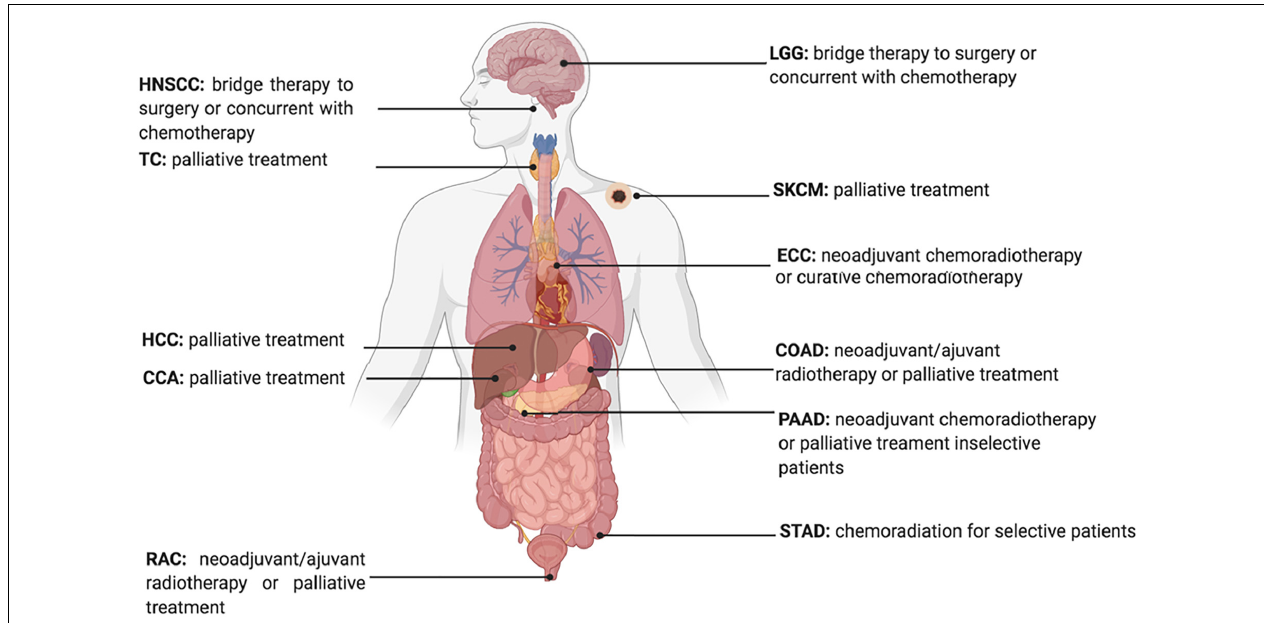
FIGURE 3 | Current Status of Radiotherapy for treatment of high ACSL4 expression tumors. HNSCC, Head and Neck squamous cell carcinoma; TC, Thyroid carcinoma; HCC, hepatocellular carcinoma; CCA, cholangiocarcinoma; RAC, Rectum adenocarcinoma; ECC, Esophageal carcinoma; LGG, Brain Lower Grade Glioma; STAD, Stomach adenocarcinoma; PAAD, Pancreatic adenocarcinoma; COAD, Colon adenocarcinoma; SKCM, Skin Cutaneous